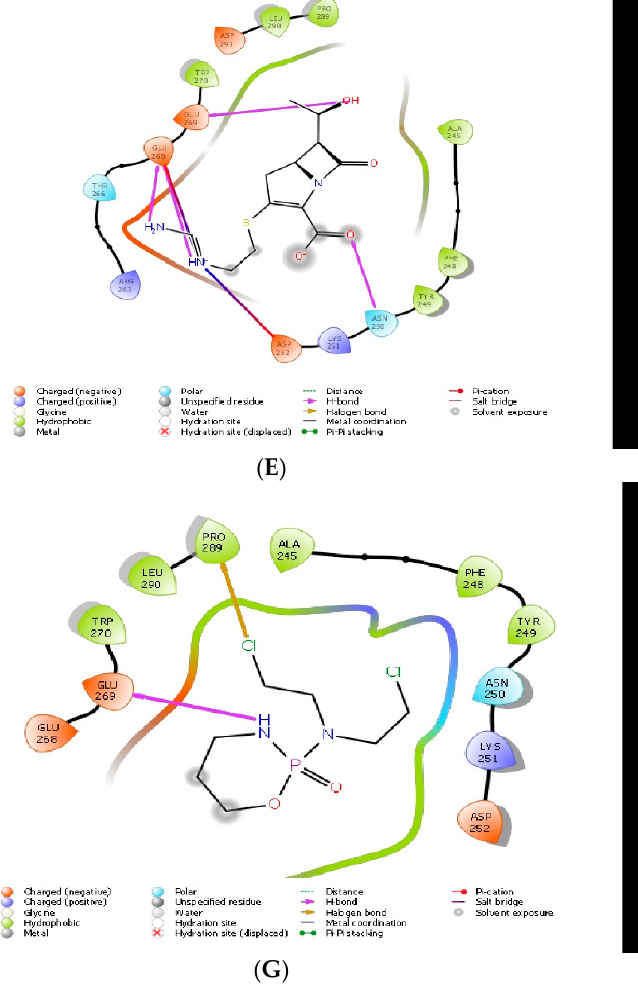
Figure 3. Molecular docking of compounds with lactobacillus bacterial protein (PDB ID: 4MKS): ( A ) 2D schematic diagram showing interactions of quercetin. ( B ) Cartoon view of lactobacillus bacterial protein with quercetin. ( C ) 2D schematic diagram showing interactions of carpaine. ( D ) Cartoon view of lactobacillus bacterial protein with carpaine. ( E ) 2D schematic diagram showing interactions of imipenem (standard). ( F ) Cartoon view of lactobacillus bacterial protein with imipenem (standard). ( G ) 2D schematic diagram showing interactions of cyclophosphamide (standard). ( H ) Cartoon view of lactobacillus bacterial protein with cyclophosphamide (standard). Residues involved in hydrogen bonding, van der Waals interactions, carbon–hydrogen, and pi–alkyl are represented in different colours indicated in the inset. Table 2. Phytochemical screening of extracts of Carica papaya